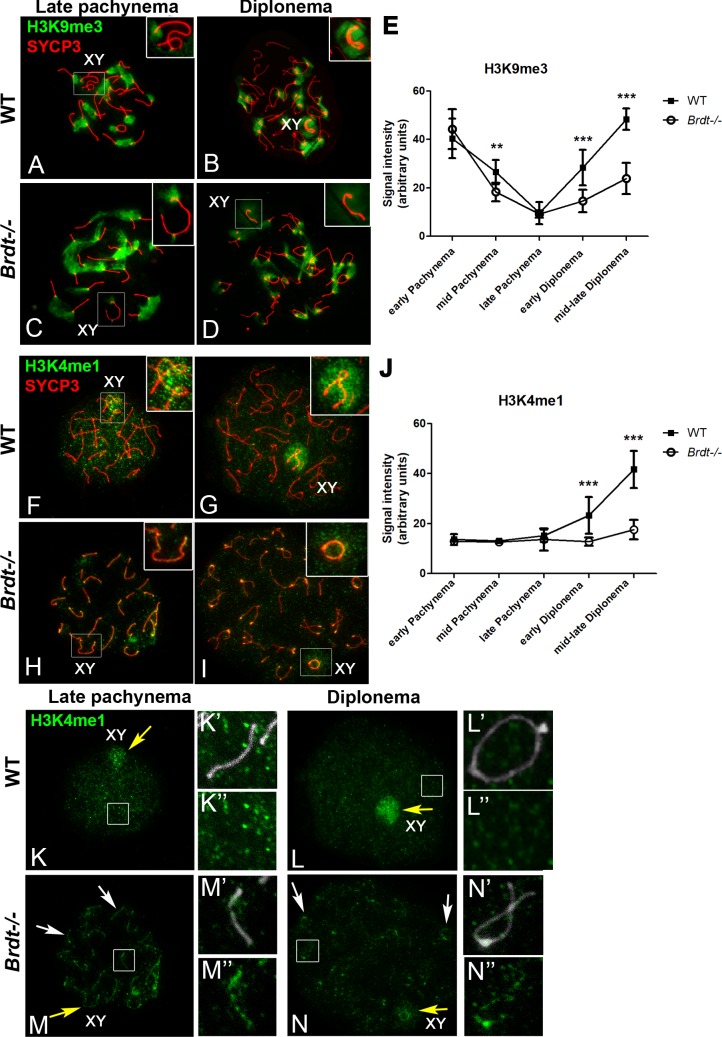
The dynamics of localization and incorporation of histone modifications linked to chromatin condensation/transcriptional repression is altered in absence of BRDT.(A-D, F-I) Chromosome spreads of wild type (WT) and Brdt-/- late pachytene and diplotene spermatocytes. Insets show an enlargement of the sex chromosomes. (A-D) Immunolocalization of H3K9me3 (green) and SYCP3 (red). (A, C) In late pachynema of both WT and Brdt-/- spermatocytes, H3K9me3 localizes only in the pericentric heterochromatin (PH) and as a very small signal in the PAR of the sex chromosomes. (B) In WT diplonema, H3K9me3 signal is intensely visualized in the PH and sex chromosomes. (D) In Brdt-/- diplotene spermatocytes, H3K9me3 staining persists in the PH but is weakly observed in the X and Y (insets). (E) Quantification of the signal intensity of H3K9me3 in the sex chromosomes in both WT (black square) and Brdt-/- (white circles) spermatocytes. Error bars indicate standard deviation. **p = 0.0072, ***p = 0.001. Samples were obtained from three 3 month-old WT and Brdt-/- mice. n = 10 and 17 early pachytene, 40 mid and 40 late pachytene, 30 early and 40 mid/late diplotene WT and Brdt-/- spermatocytes, respectively, per mouse. (F-I) Immunolocalization of H3K4me1 (green) and SYCP3 (red). (F) In WT late pachytene spermatocytes, H3K4me1 localizes throughout the chromatin of the autosomes and is slightly more intense in the sex chromosomes. (G) In diplonema, the signal intensity of H3K4me1 in the X and Y is notably increased (inset). (H) In Brdt-/- late pachytene spermatocytes, H3K4me1 signal starts to appear very faint throughout the chromatin from both autosomes and sex chromosomes (inset). (I) In diplonema, H3K4me1 remains weak in the X and Y (inset). (J) Quantification of the signal intensity of H3K4me1 in the sex chromosomes in both WT (black square) and Brdt-/- (white circles) spermatocytes. Error bars indicate standard deviation. *** p = 0.001. Samples were obtained from three 3 month-old WT and Brdt-/- mice. n = 13 early pachytene, 30 mid pachytene, 40 and 50 late pachytene, 30 early and 30 mid/late diplotene WT and Brdt-/- spermatocytes, respectively. (K-N) The same chromosome spreads of WT and Brdt-/- late pachytene and diplotene spermatocytes shown in F-I, but only H3K4me1 is displayed. (K’-N”) Enlargement of the chromosomes demarcated by the white rectangle in (K-N), with the chromosomes identified by SYCP3 (grey) in (K’-N’). (K-N) Yellow arrow indicates the sex body. (J-K”) In WT spermatocytes H3K4me1 is homogeneously distributed throughout the chromatin and is more concentrated in the sex chromosomes (yellow arrow). (M-N”) In the absence of BRDT, H3K4me1 is mainly located in the chromatin adjacent to the SC (white arrows, M-N”‘).